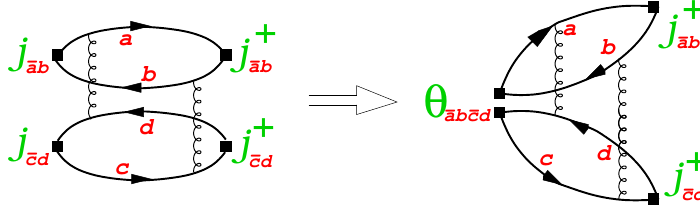
Figure 2. Definitely flavor-exotic four-current correlation function (7) of flavor-preserving type ( left ) and ( right ) contraction (9) to a correlation function of one tetraquark interpolating operator (6) and two quark-bilinear currents (5) [30]: typical contribution of lowest tetraquark-phile perturbative order O ( α 2 s ) .